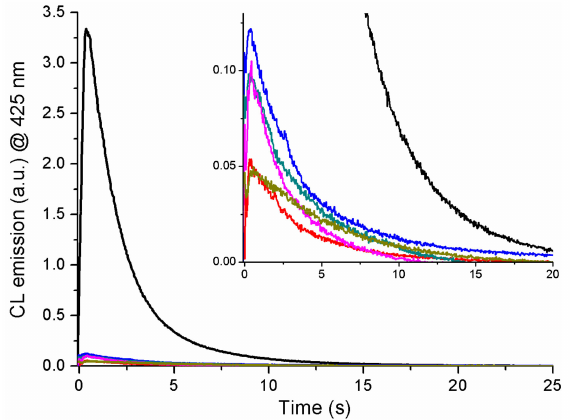
Figure 2. Results of a typical experiment to determine the chemiluminescence of the amino-acylated derivatives 1a (blue), 1b (green), 1c (red), 1d (magenta), 1e (olive), and luminol (black) in aqueous basic solutions. Inset: magnification. Table 1. CL quantum yields of phthalhydrazides 1 , 12 , and luminol